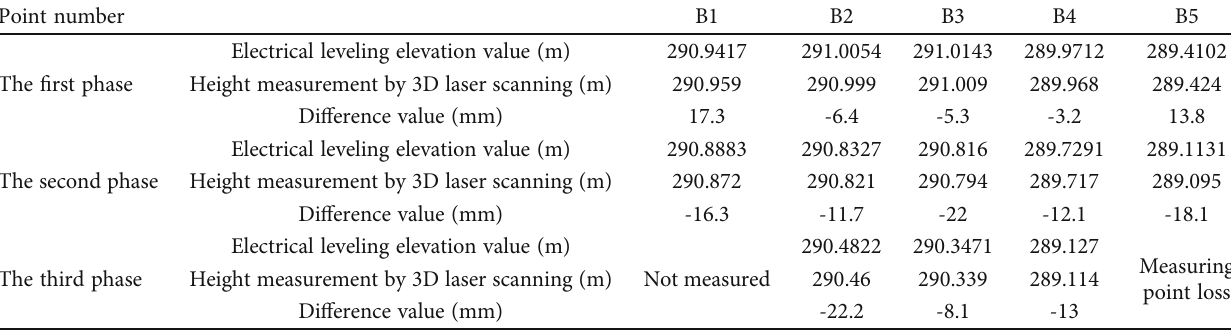
Table 1: Elevation value comparison in leveling and TLS.